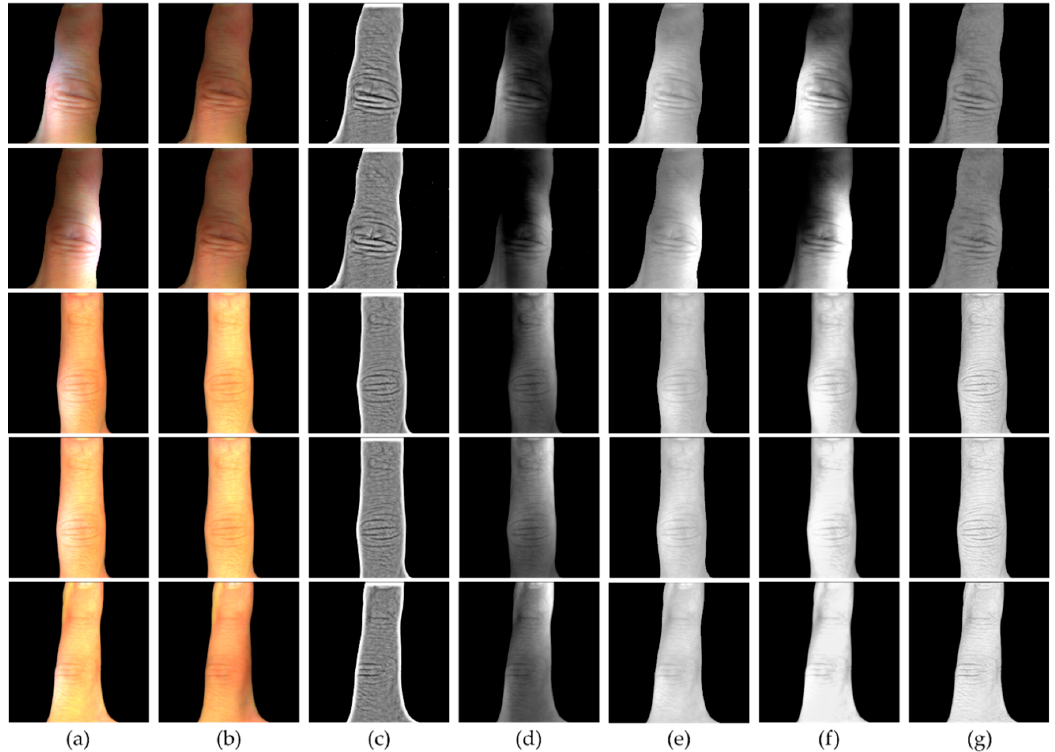
Figure 9. The qualitative comparison results with existing methods: ( a ) original images captured from a Lytro camera under various illumination conditions; ( b ) reference images; ( c ) TT [36]; ( d ) CIDRE